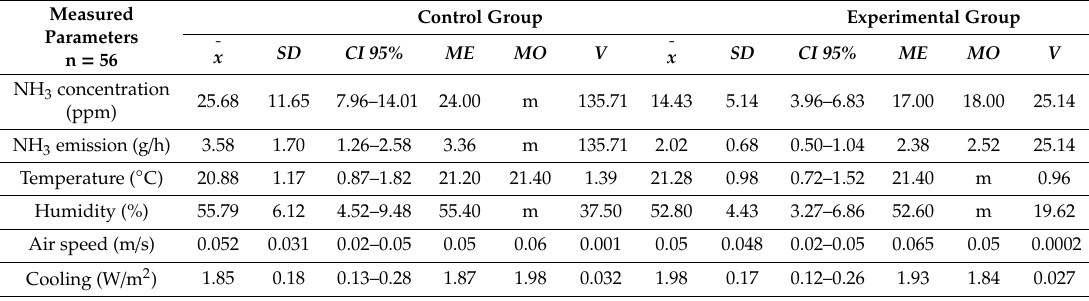
Table 1. Ammonia concentration, emission and microclimate parameters determined during the experiment in the control group (group C) and the experimental group (group E).